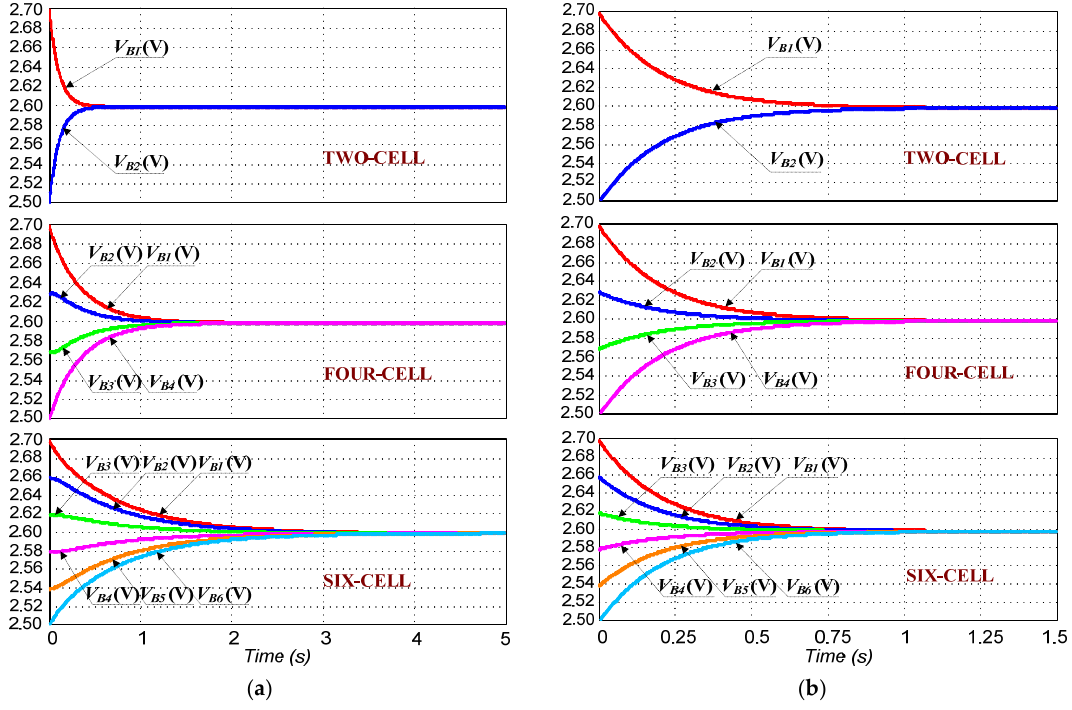
Figure 10. Simulation waveforms of the balancing process: ( a ) conventional one; ( b ) proposed one.